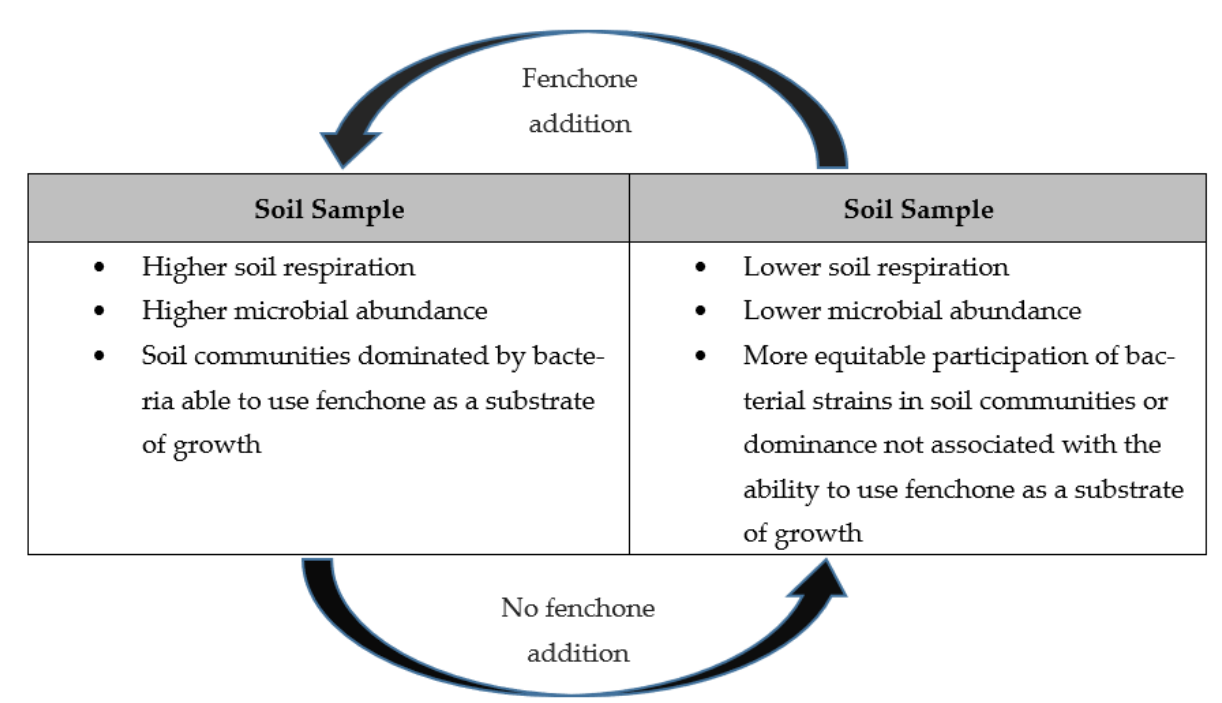
Scheme 1. Representation of the cycle of events associated with presence or absence of fenchone.